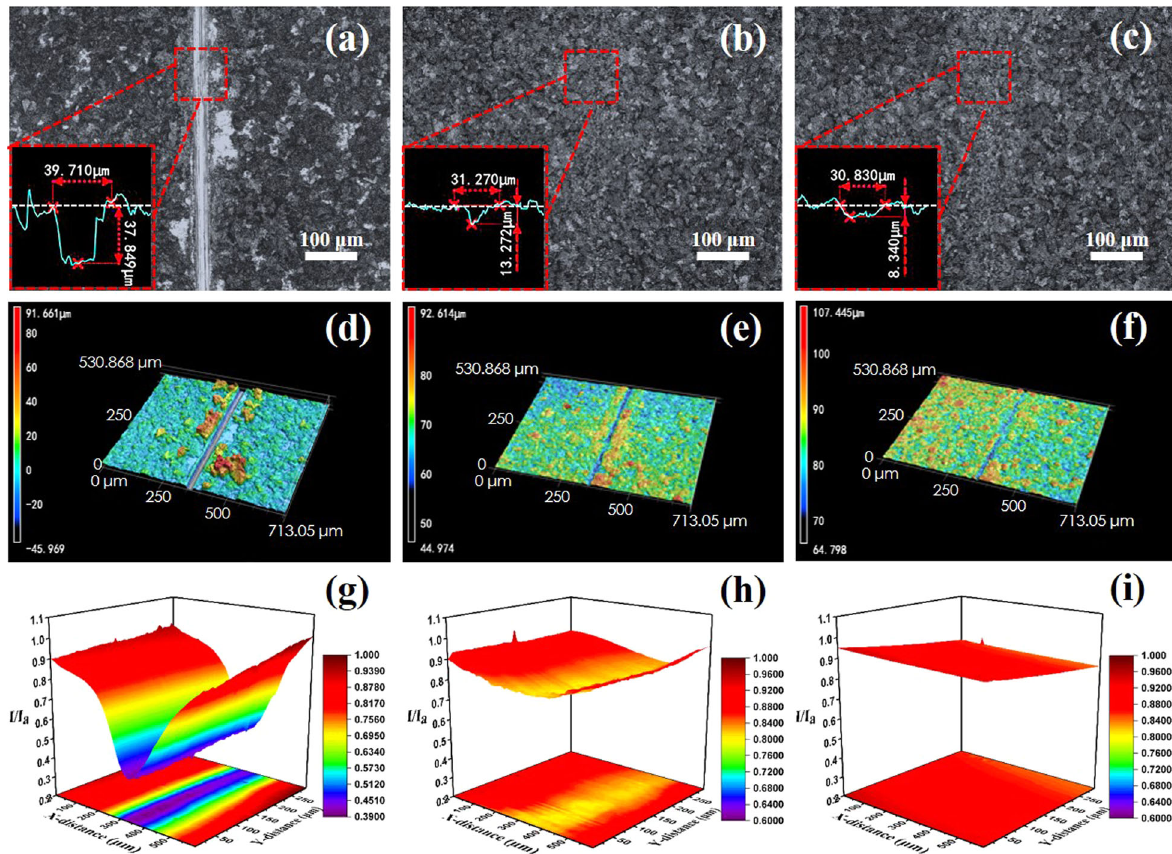
Fig. 9 Stereo-optical micrographs and SECM images of a coating scratch during the S. putrefaciens -induced microbial self-healing process. a , d , g Before microbial self-healing; b , e , h immersion for 7 days in the S. putrefaciens -inoculated medium; c , f , i immersion for 14 days in the S. putrefaciens -inoculated